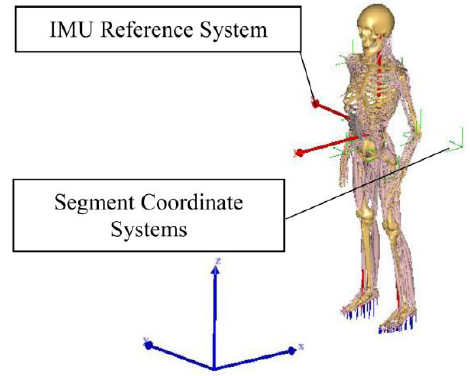
Figure 11. Musculoskeletal model designed by [60]. The coordinate frame within the hip represents the reference system for the IMUs.